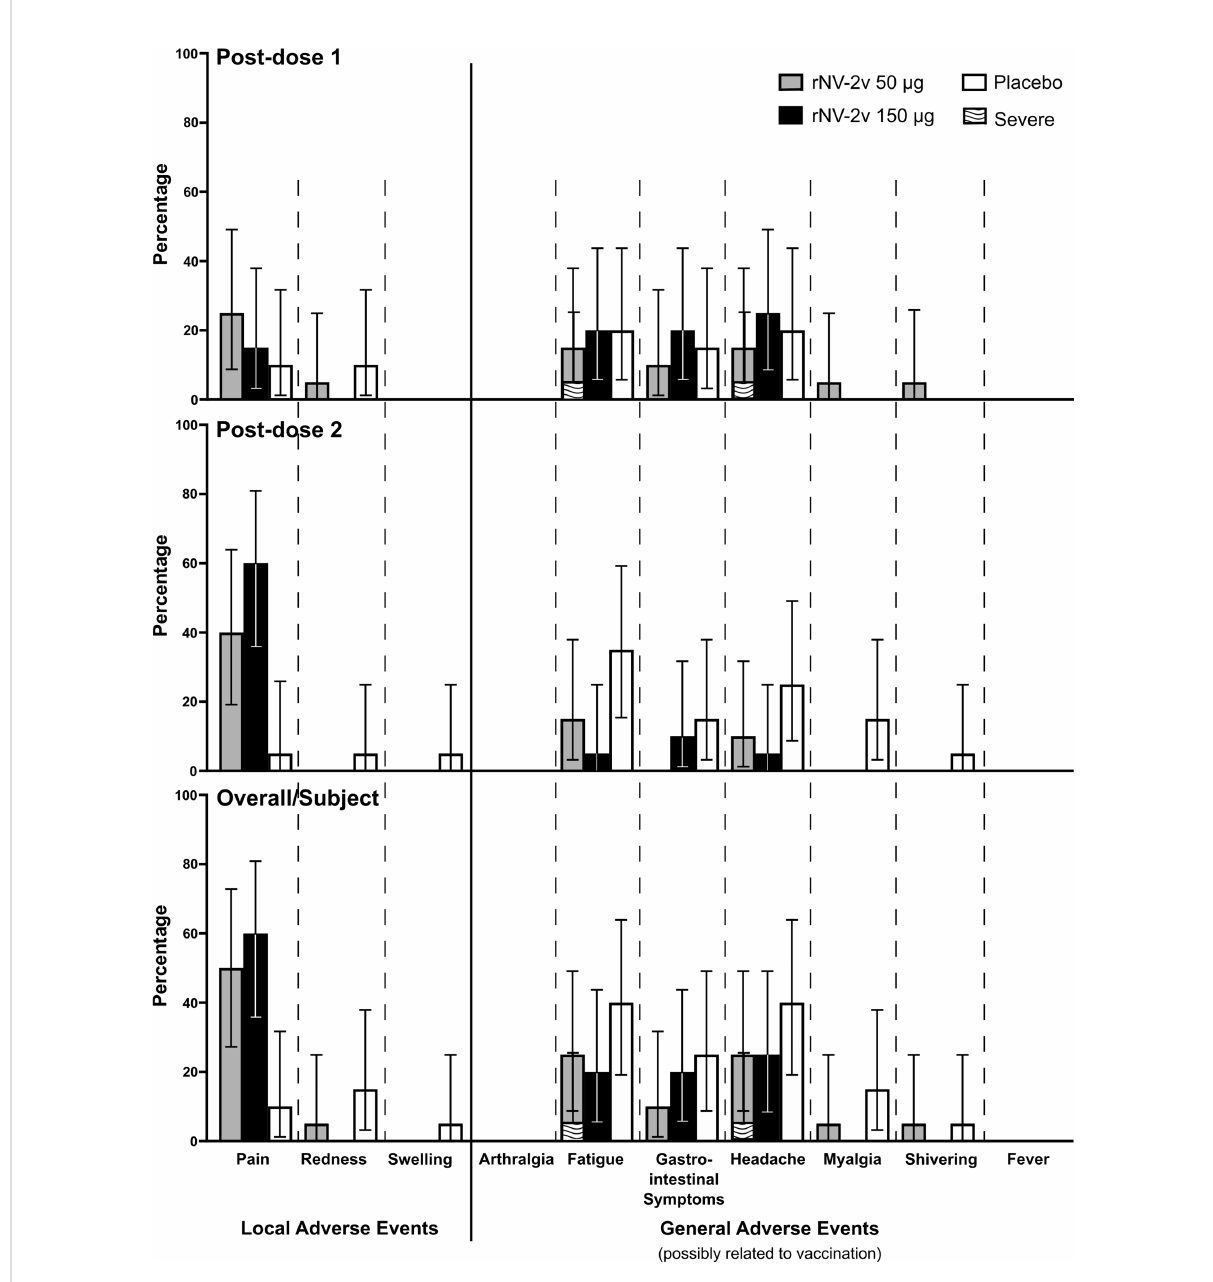
FIGURE 3 Solicited local and general adverse events during the 7-day post-vaccination period. Percentages of participants (with exact 95% con fi dence intervals) reporting solicited local adverse events (pain, redness and swelling) and general adverse events (arthralgia, fatigue, gastrointestinal symptoms, headache, myalgia, shivering and fever) possibly related to the vaccination during the 7-day post-vaccination period after each dose and overall per subject. Gastrointestinal symptoms de fi ned as nausea, vomiting, diarrhea and/or abdominal pain. Fever de fi ned as temperature ≥ 38.0°C. Error bars for zero values are omitted for the sake of